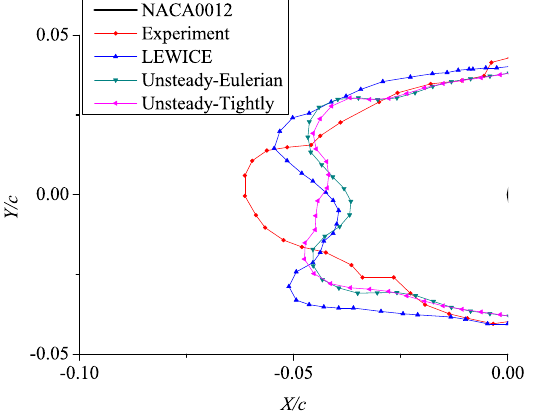
Figure 20. Enlarged view of the comparison of ice shapes at the leading edge of an airfoil.